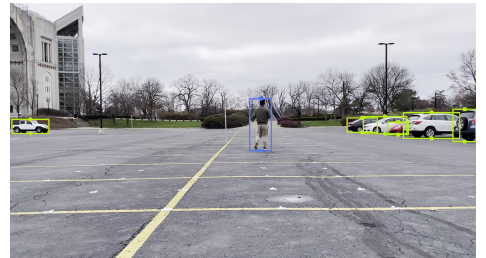
Figure 4. A diagram demonstrates HE-Net inverse projection Figure 3. Object detection output generated by the detection process. Lilac and blue canvases respectively represent image network in the form of a bounding box: b i,j, 1 , b i,j, 2 , b i,j, 3 , b i,j, 4 . plane and object plane vertical to the horizontal road plane Marked two points (middle bottom and middle above) of the (black canvas). Two dotted inverse projection lines originating bounding box represent object bottom and top, such that the from camera pinhole (black point) project object through image object height is the the length of the line connecting these two plane back to object plane at a distance of z . points.